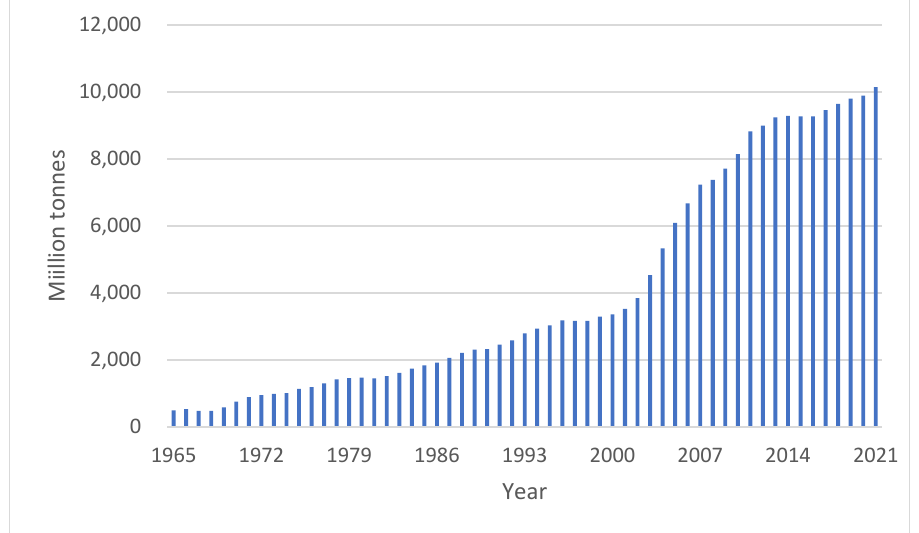
Figure 1. Carbon dioxide emissions in China.